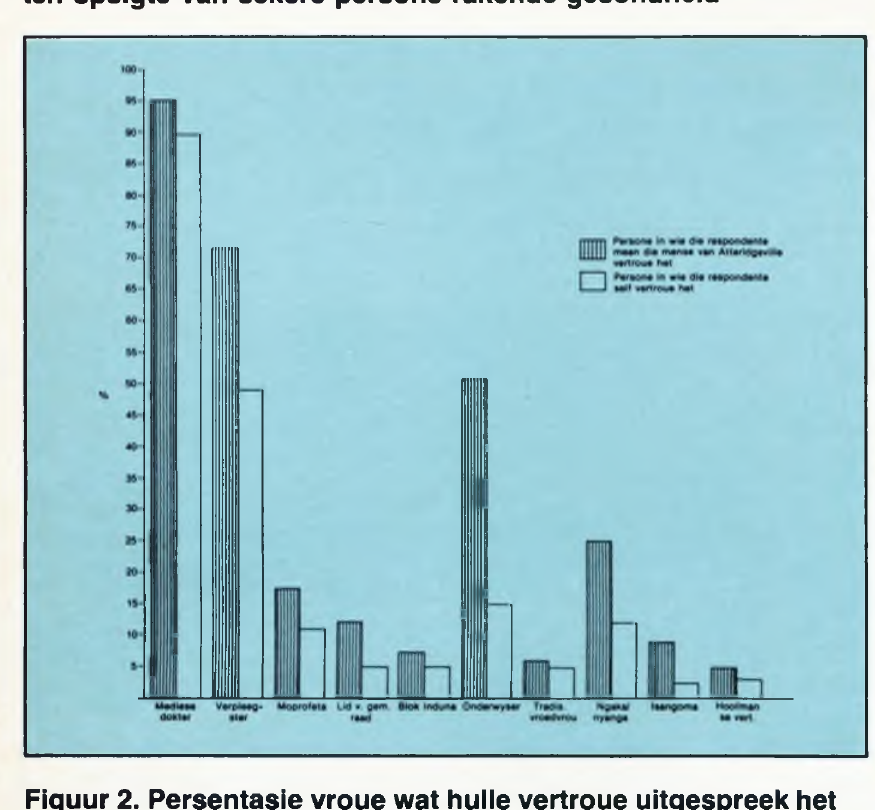
Figuur 2. Persentasie vroue wat hulle vertroue uitgespreek het ten opsigte van sekere persone rakende